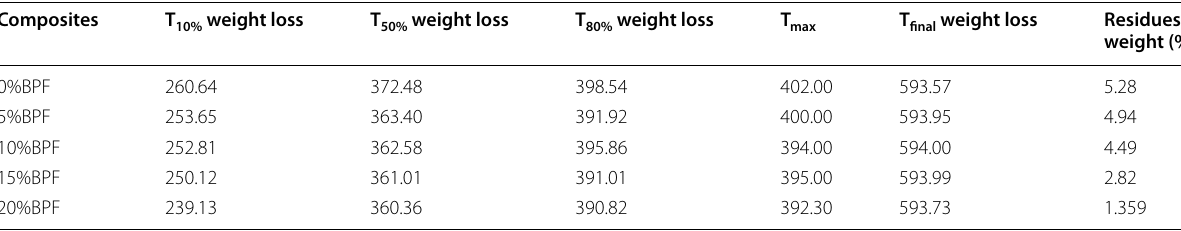
Table 3 Degradation temperatures of composites with BPF